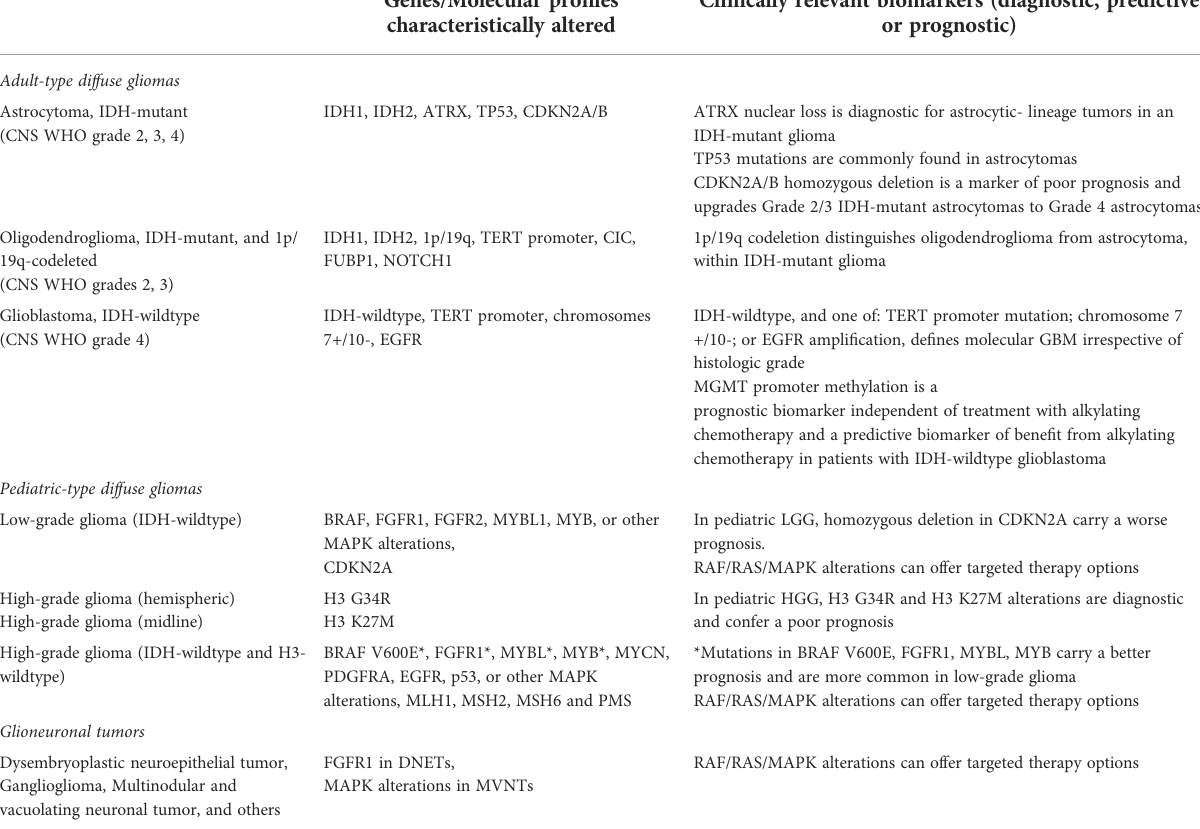
TABLE 1 Recommended biomarkers for testing and their clinical implications in AYA